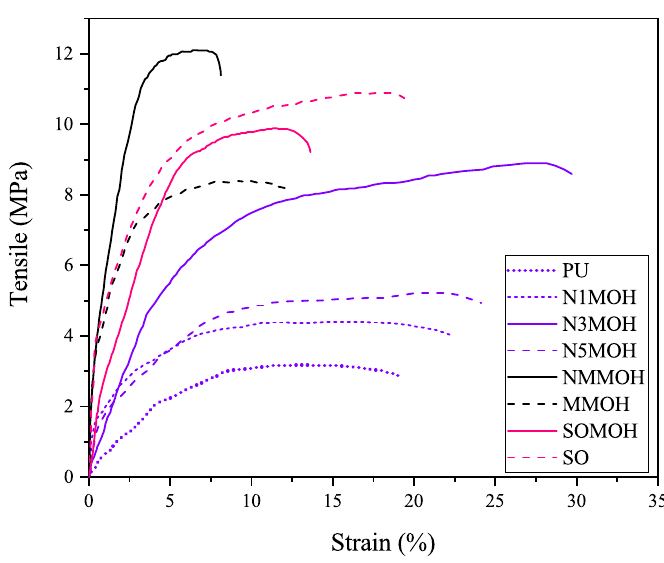
Figure 10. Stress-–strain curves of the nano-, micro-, and hybrid PU composite samples.